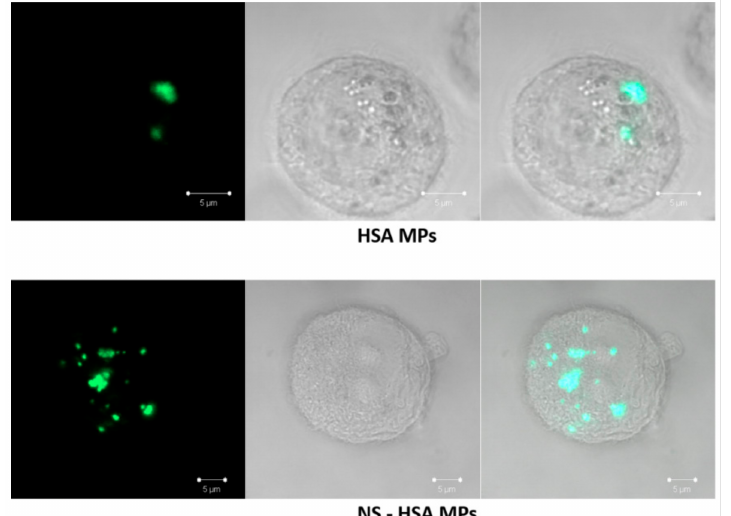
Figure 8. Uptake of FITC labeled HSA MPs and NS-HSA MPs inside A549 cells after incubation for 24 h. Each particle was detected in the Z-stacks pattern under a confocal laser scanning microscope (CLSM) with fluorescence, bright field, and merging image,